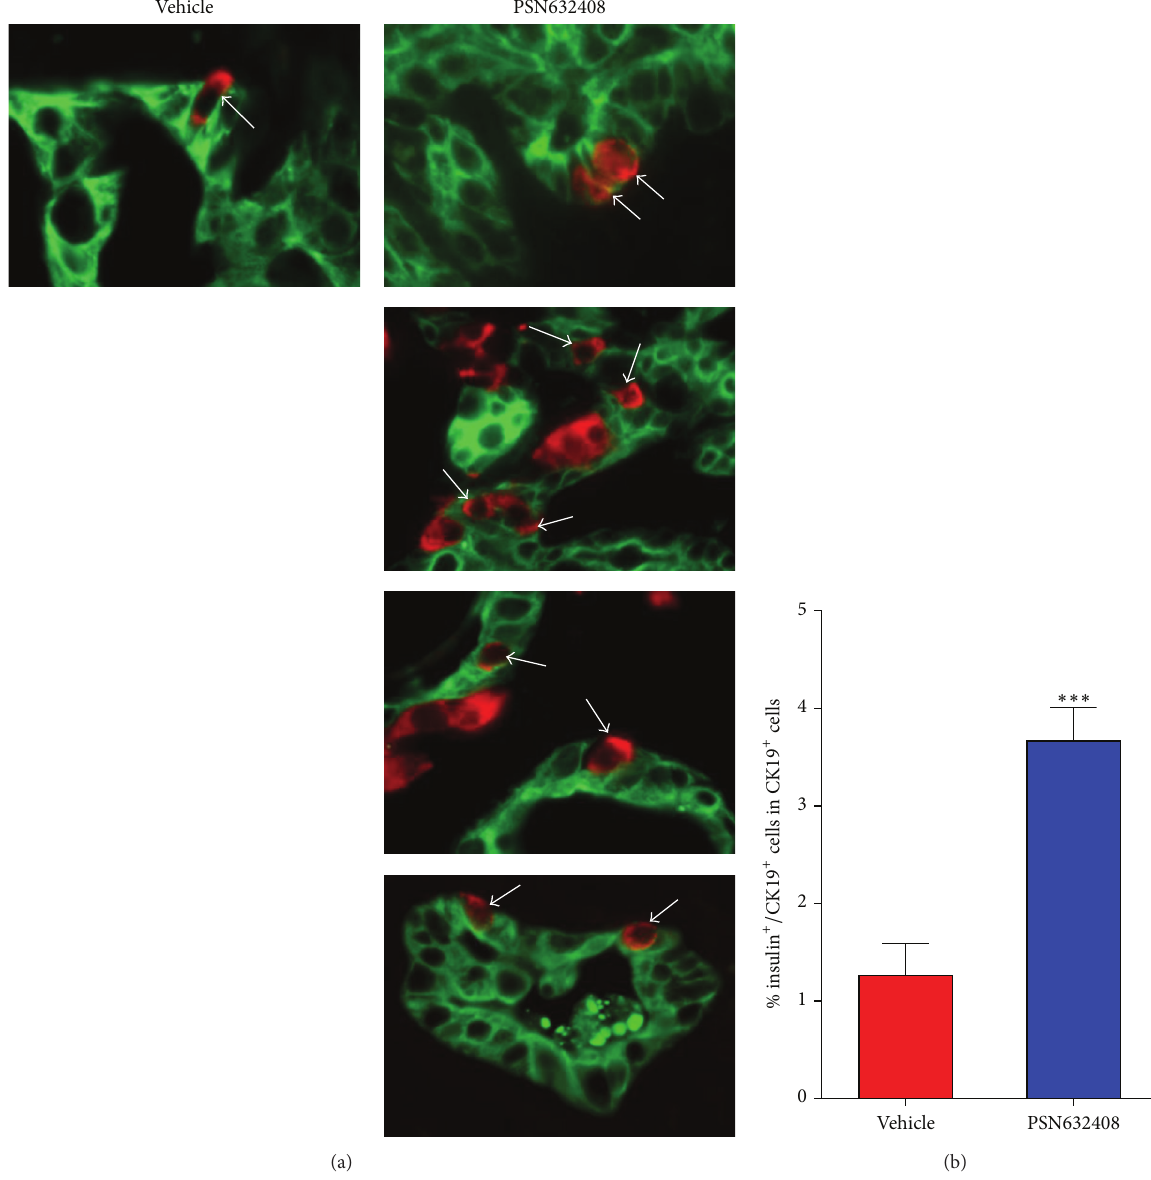
Figure 6: (a) Immunofluorescent staining for insulin (red color) and CK19 (green color) in human islet grafts in PSN632408- and vehicle- treated mice with normoglycaemia at 4 weeks after transplantation. White arrows show insulin/CK19 copositive cells in human islets grafts. (b) Percentage of insulin/CK19 copositive cells among total CK19 positive duct cells in human islet grafts. The average percent of insulin/CK19 copositive cells among total CK19 positive duct cells was significantly higher in mice treated with PSN632408 ( 𝑛 = 9 ) compared with mice treated with vehicle ( 𝑛 = 4 ) ( ∗∗∗ 𝑃 < 0.001